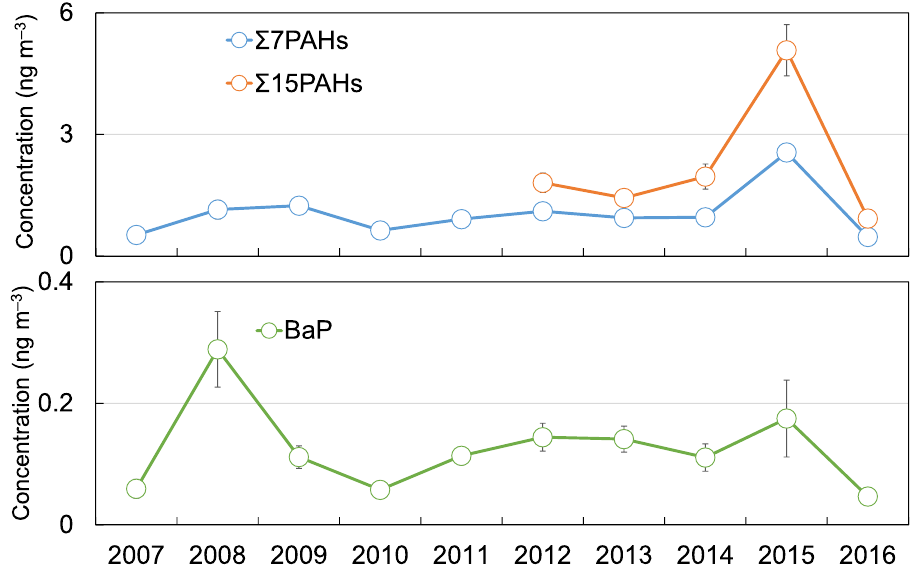
Figure 1. Average annual ΣPAH and BaP concentrations,